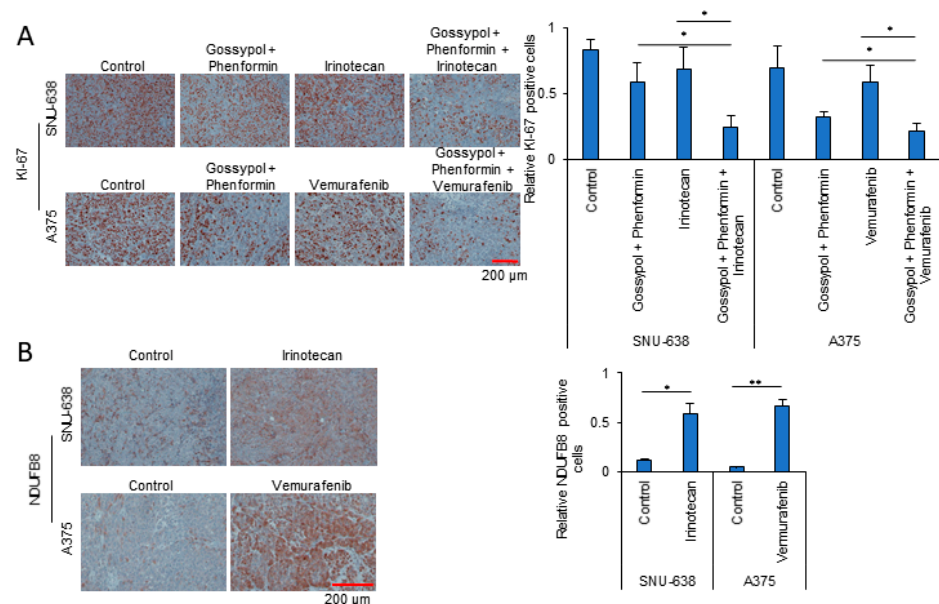
Figure 6. Synergistic anticancer effect of irinotecan treatment with OxPhos inhibitors. ( A ) Representative images showing immunohistochemical staining with anti-Ki-67 as a measure of tumor proliferative activity in the SNU-638 and A375 xenograft models used in Figure 5. ( B ) Representative images showing immunohistochemical staining with anti-NDUFB8 (mitochondrial complex I) as a measure of OxPhos activity in tumors from SNU-638 and A375 xenograft control and anticancer drug treatment groups. P values were analyzed by unpaired two-tailed Student's t test. p < 0.05; **, p < 0.01; ***, p < 0.001.